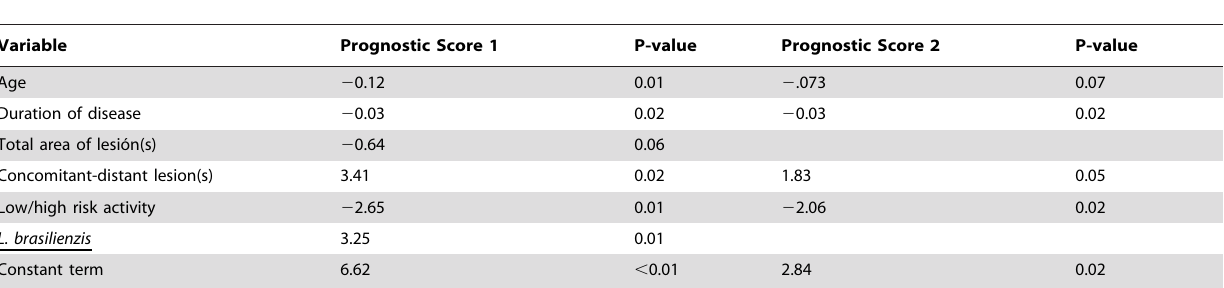
Table 4. Regression coefficients of the logistic models for chemotherapy failure.